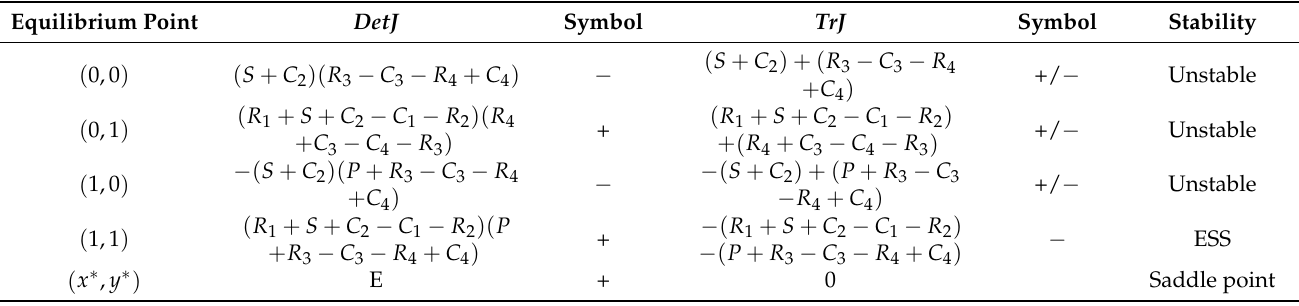
Table 6. Local stability analysis of the evolutionary game system with government intervention.